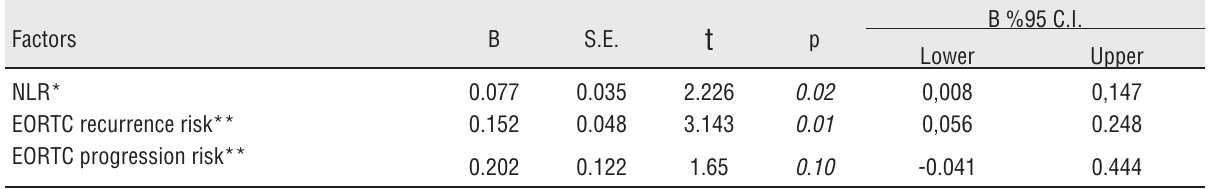
Table 2 - Logistic regression analysis for response to